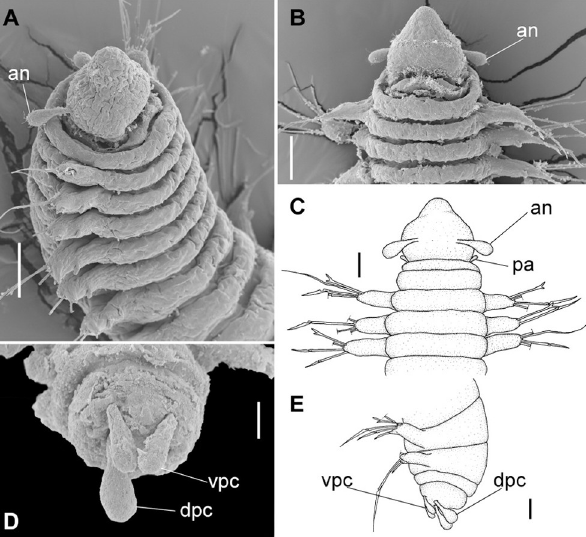
Fig 14. Meiodorvillea hartmanae sp. nov. (A) anterior region, ventrolateral view; (B) anterior region, ventral view; (C) anterior region, dorsal view; (D) pygidium, ventral view; (E) pygidium, lateral view. Abbreviations: an = antenna; dpc = dorsal pygidial cirrus; pa = palp; vpc = ventral pygidial cirrus. Scale bars: (A) = 40 μ m; (B) = 25 μ m; (C,E) = 31.25 μ m; (D) = 20 μ m. ventralmost compound in last chaetigers (Fig 16H). Chaetae gradually slender and longer along body. One internal thick acicula (Fig 15B and 15D). Pygidium rounded and narrower than previous chaetigers. Two pairs of clavate pygidial cirri, dorsal pair twice as long as ventral pair (Figs 13E, 14D and 14E). Jaw apparatus from additional non-type material with ventral and medially fused mandi- bles, anterior region enlarged with smooth margins without free or fused teeth, posterior region slender and curved (Fig 17A). Basal plates of maxillae with smooth inner margin, two subsymmetrical rows with 10–12 pairs of free rectangular and denticulate maxillary plates, each one with one posterior main fang and usually four anterior teeth last and anteriormost plates larger and rounded, with small and more numerous teeth. (Fig 17A–17C). Variation. Complete specimens 1.5–2.9 mm long, maximum width 0.28 mm, 28–48 chae- tigers; some with posterior moniliform segments (width equal to length). Palps visible only ventrally in some specimens. Most specimens with cultriform chaetae, with serrated cutting